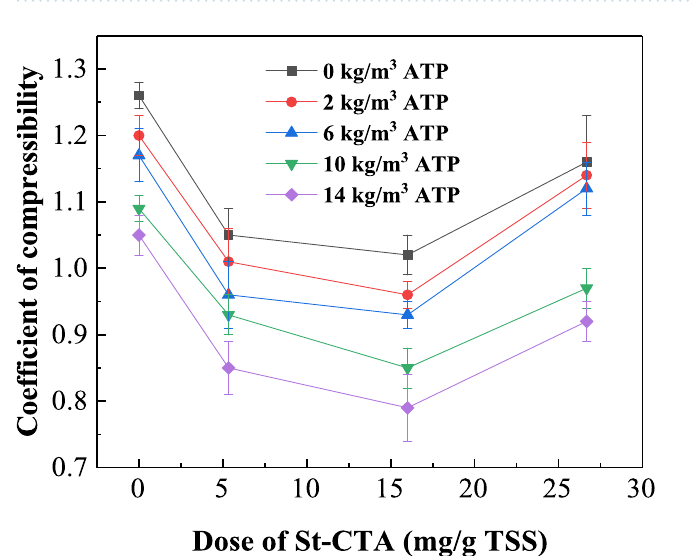
Figure 1. The sludge dewatering performance of St-CTA in conjunction with ATP by using different doses: ( a ) FCMC, ( b ) SRF, ( c ) CST and ( d ) TTF.